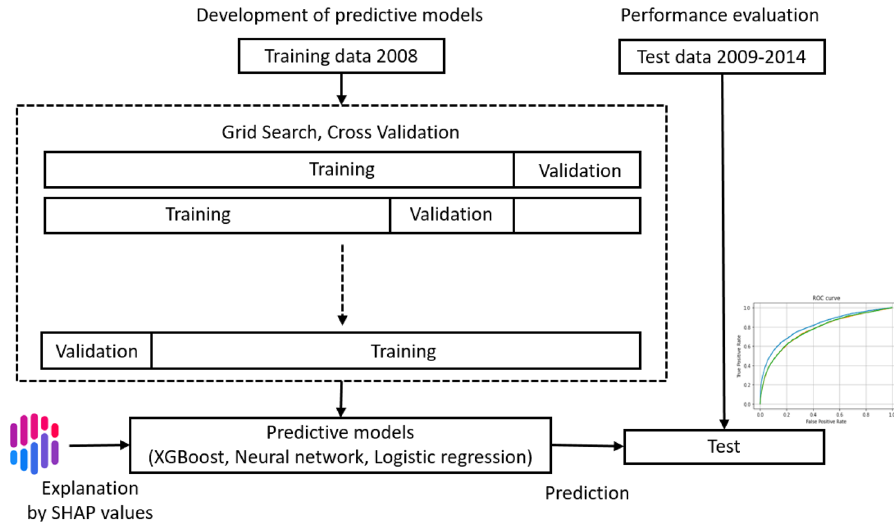
Figure 5. Workflow diagram of development and performance evaluation of predictive